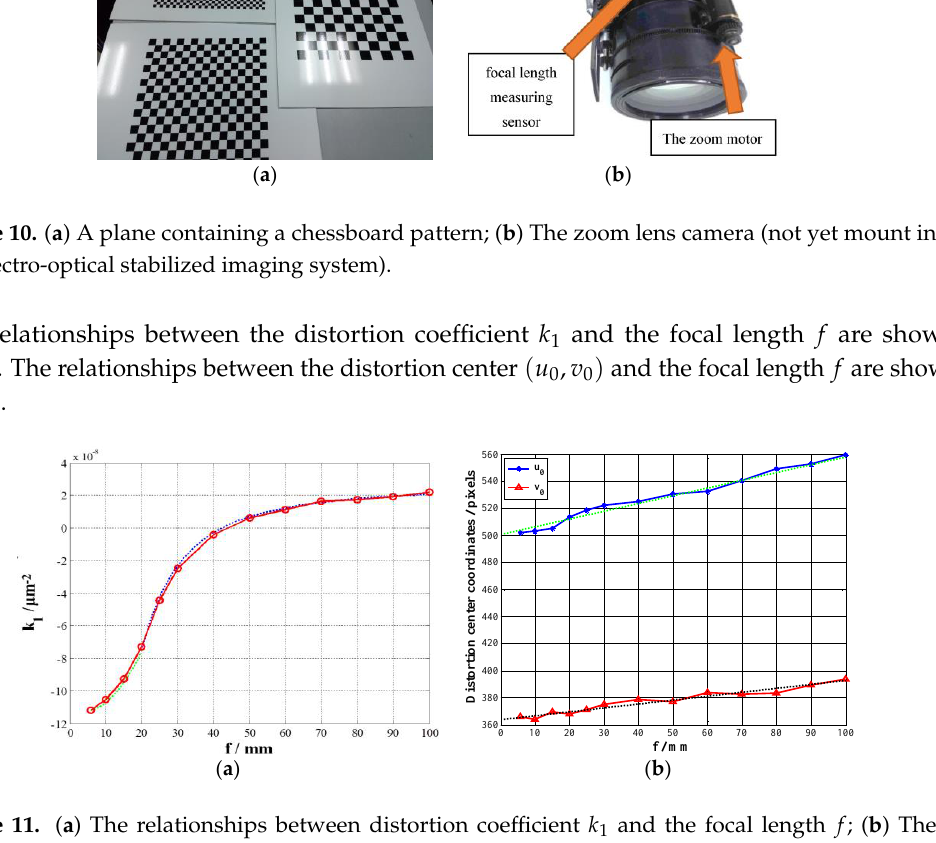
Figure 11. ( a ) The relationships between distortion coefficient 𝑘 1 and the focal length 𝑓; ( b ) The relationships between the distortion center (𝑢 0 ,𝑣 0 ) and the focal length 𝑓 .